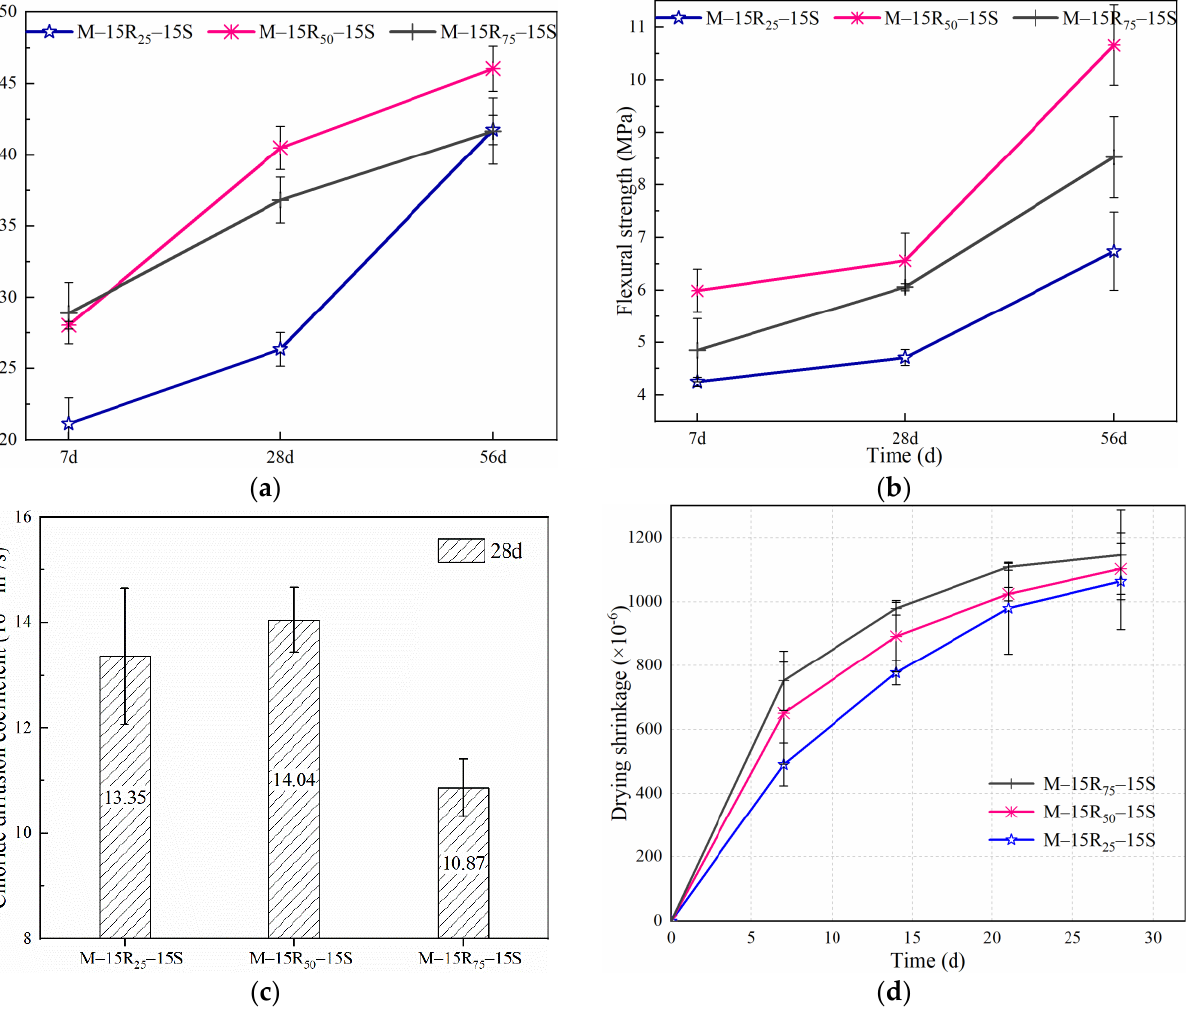
Figure 5. Effect of RCP grinding time on properties of eco-efficient mortar in Series B: ( a ) compressive strength, ( b ) flexural strength, ( c ) chloride migration coefficient, and ( d ) drying shrinkage.